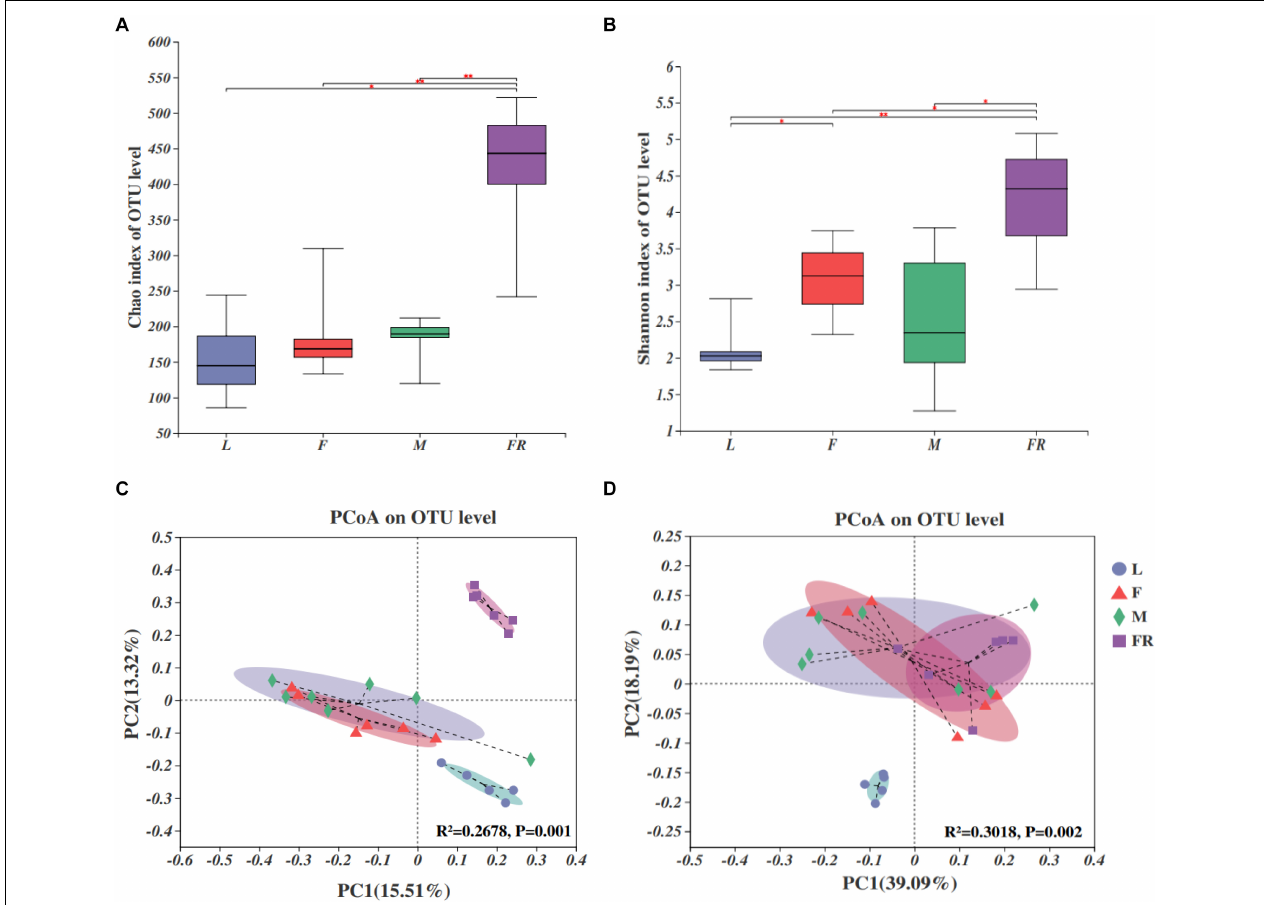
FIGURE 2 | Bacterial communities in the Sirex noctilio gut and frass. Boxplots of (A) species richness (Chao index), and (B) species diversity (Shannon index). The significant differences of alpha diversities were analyzed using Wilcoxon rank-sum test ( ∗ 0.01 < P ≤ 0.05, ∗∗ 0.001 < P ≤ 0.01). (C) Unweighted and (D) weighted UniFrac-based PCoA plots of bacterial communities. The significant differences in beta diversities were analyzed using adonis analysis with 999 Monte Carlo permutations (L, larva; F, female; M, male; and FR,